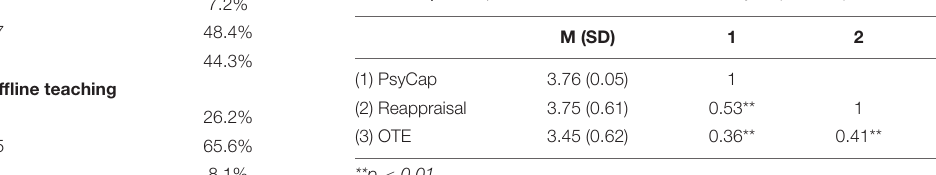
TABLE 2 | Descriptive statistics and correlation analysis ( N =